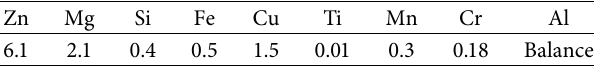
Table 1: Chemical composition of Al7075 alloy by weight%.